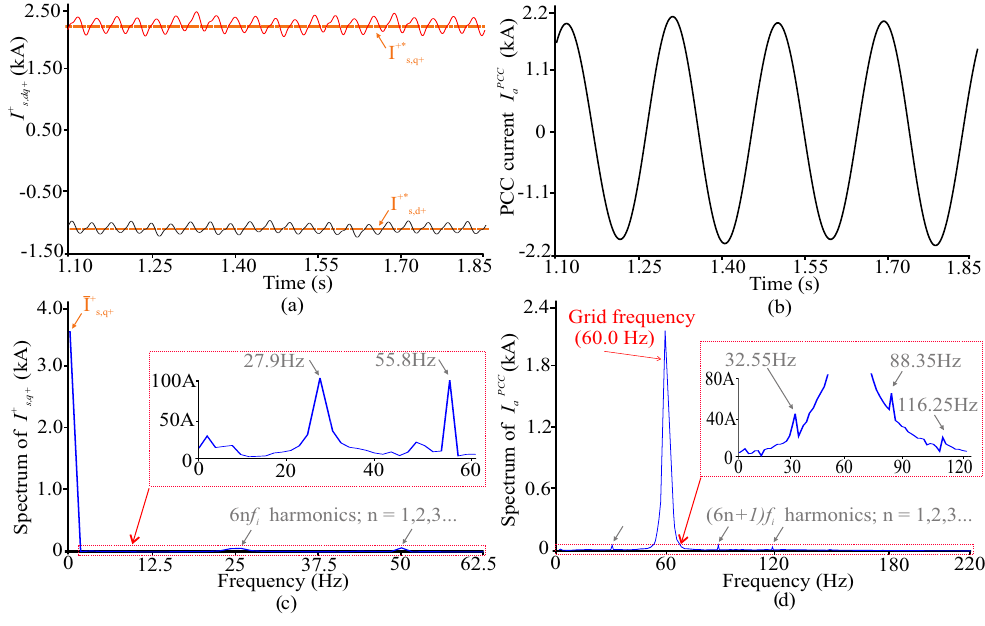
Figure 6. ( a ) SCIG I + stator currents in dq + . ( b ) Phase a stator current in natural frame. ( c ) I + s , dq spectrum. ( d ) Spectrum of phase “ a ” stator current in natural